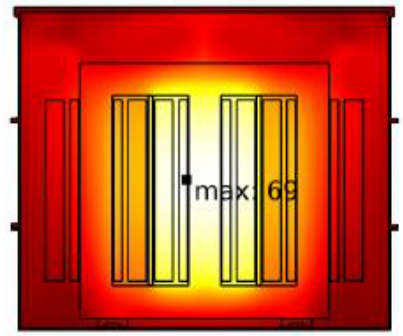
Figure 16. Temperature distribution (hot points) inside the tank for ( a ) 2D and ( b ) 2D axial symmetry analysis for R410A gas insulated transformer. Under the same conditions, the value for the hot spot was found to be 69 °C for SF6 gas insulated transformer and 62.69 °C for oil-insulated transformer in 2D analysis. The results are shown in Figures 17 and 18.